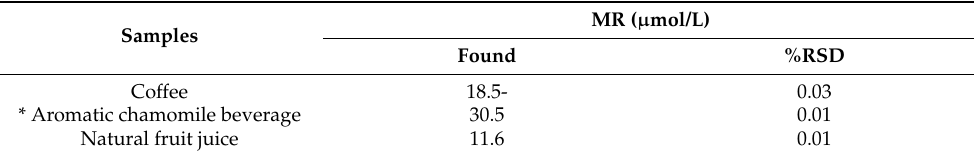
Table 4. Analysis of real samples ( n = 3).